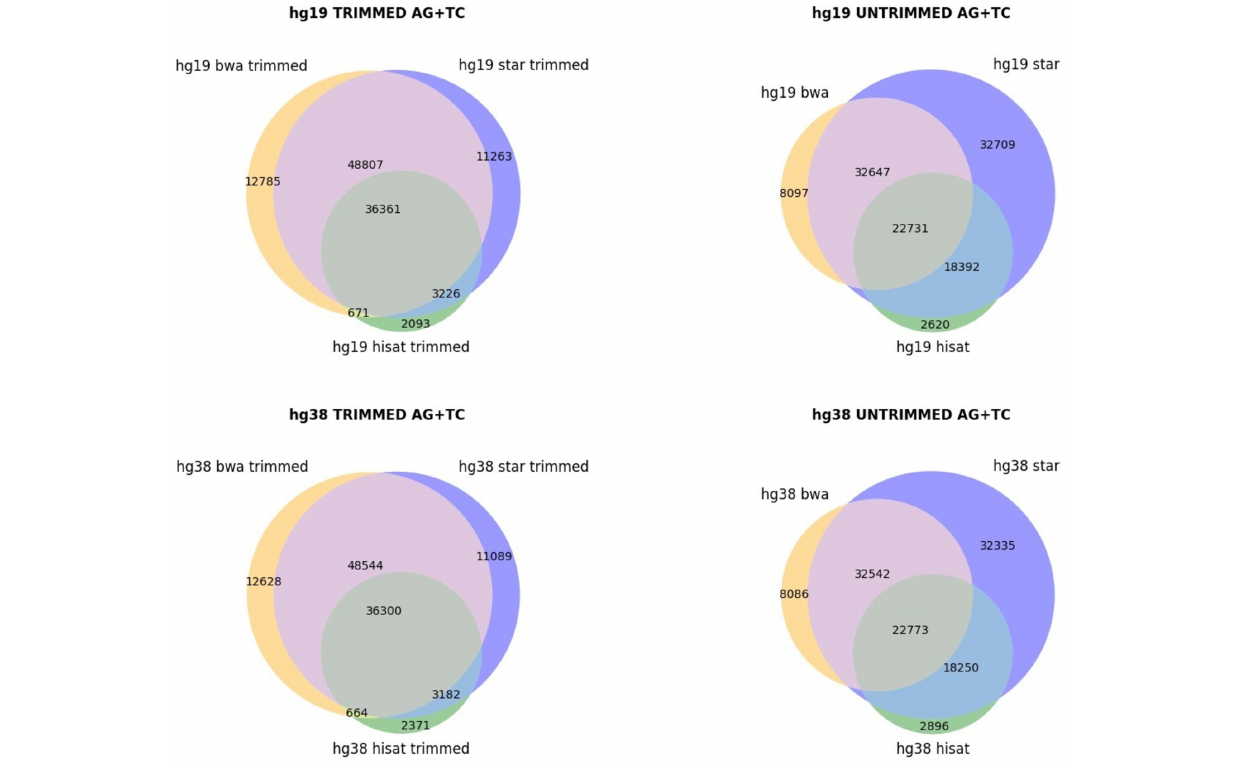
depending on the processing steps, suggesting that the trimming procedure as well as the aligner type affect the detection of RNA editing. The three different aligners resulted in different results, reflecting the slightly different algorithms. STAR has returned the highest number of candidates. Surprisingly, HISAT2 yielded the lowest number of variants, even though it is splice-aware and did align the same proportion of reads as STAR ( Figure 1 and Supplementary Table S2